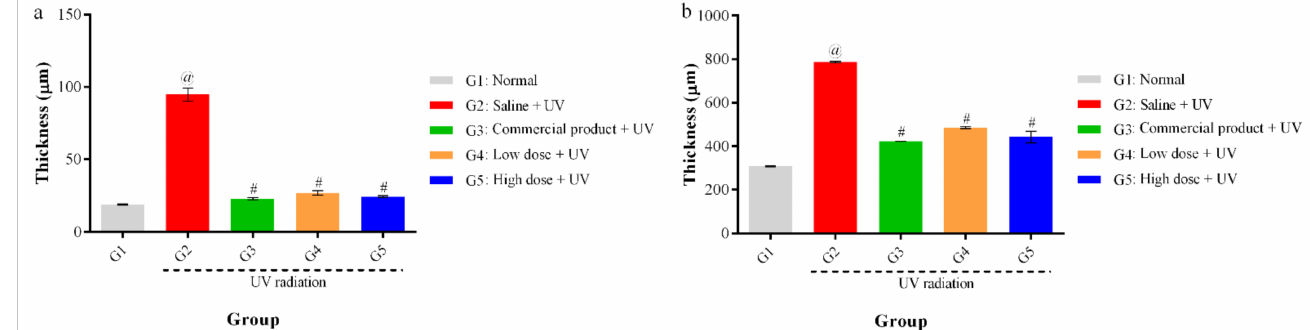
Figure 9. Effect of treatment on the thickness of ( a ) epidermis, ( b ) dermis. @: significant difference in comparison to normal group #: significant difference in comparison to control group p < 0.05/ n = 10.